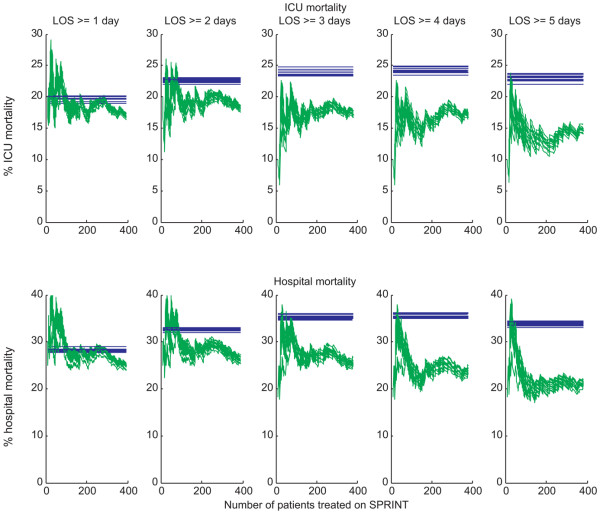
Comparison of intensive care unit (ICU) mortality and in-hospital mortality between Specialised Relative Insulin Nutrition Tables (SPRINT) and retrospective patients for several iterations of the patient selection procedure detailed in Figure 1. The top row of plots shows ICU mortality, and the bottom row of plots shows hospital mortality. The retrospective mortality average is shown by the horizontal line, and mortality since initiation of SPRINT is shown by the variable line. The horizontal axis represents the total number of patients treated with the SPRINT protocol. The plots are grouped by length of ICU stay (LOS). The spread of lines results from the random patient selection process.